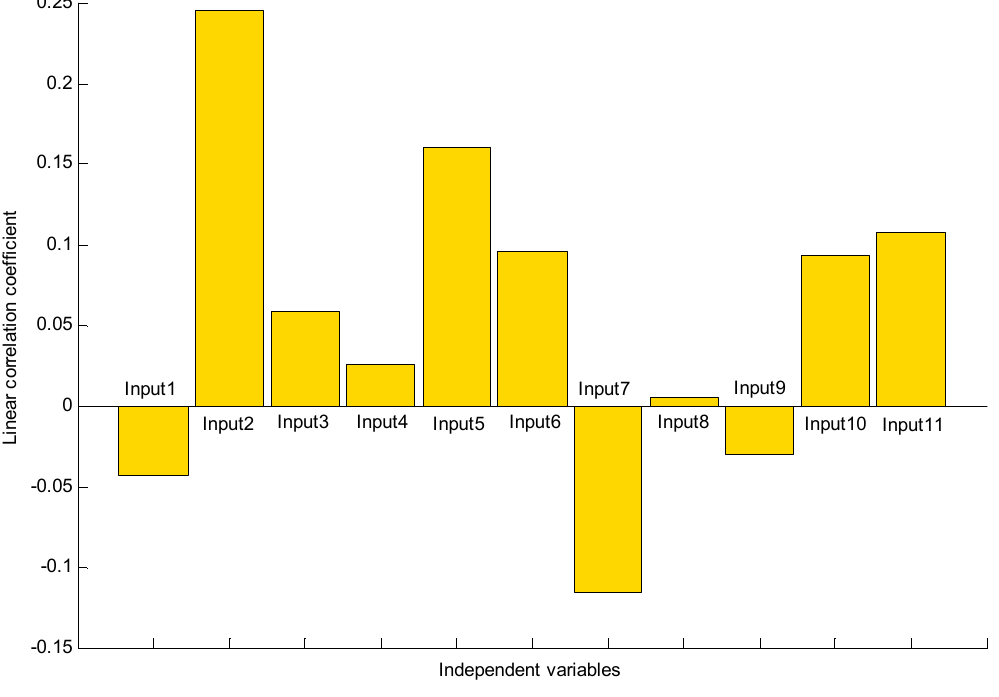
Figure 3. Pearson correlation coefficient values among independent and dependent variables.